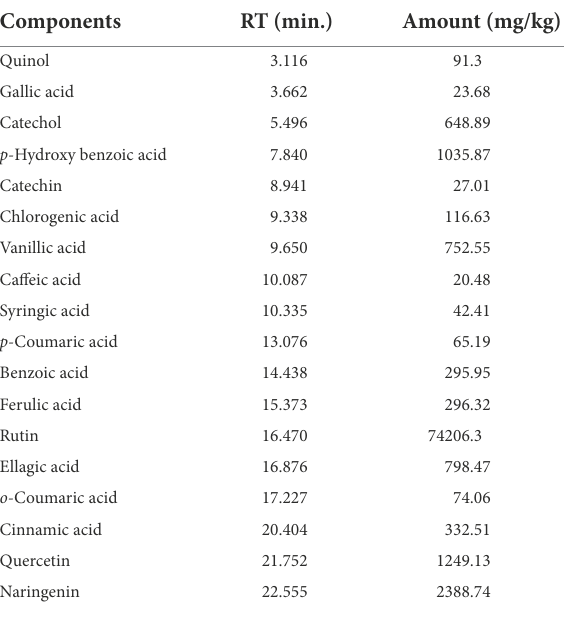
TABLE 6 Phenolic and flavonoid components identified in Plantago lagopus extract.